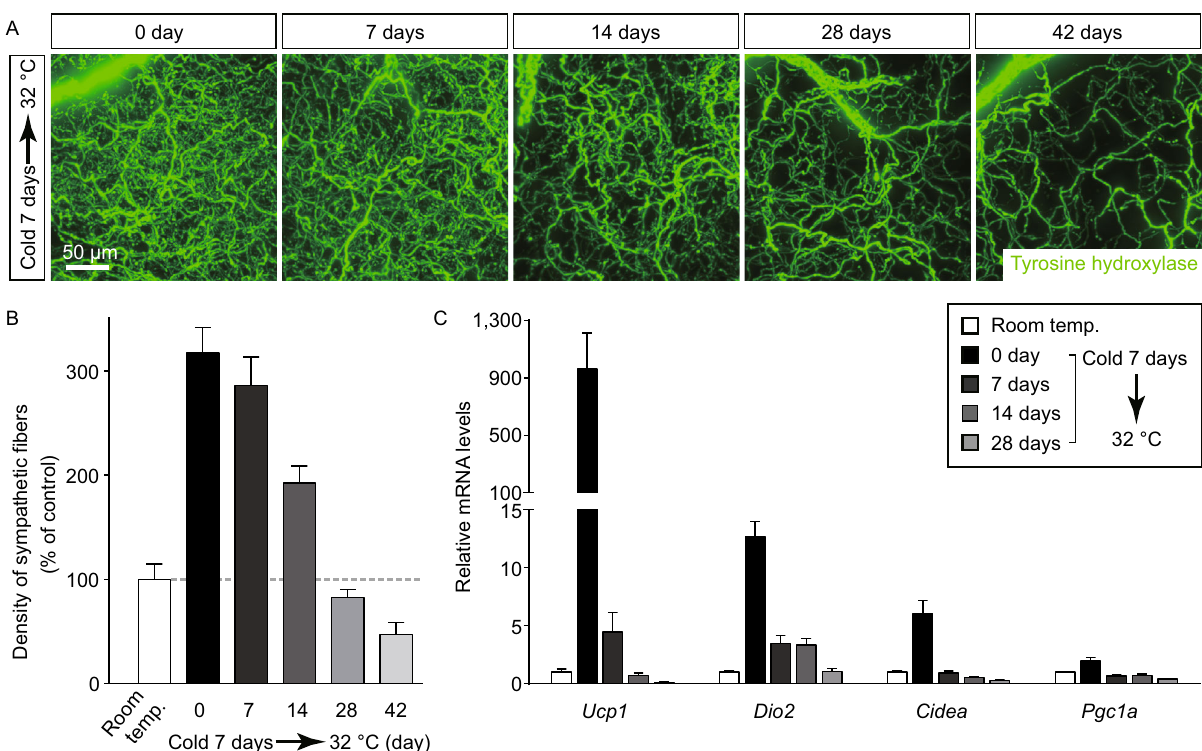
Figure 2. Cold-induced intra-adipose sympathetic plasticity is reversible. The wildtype mice were subject to cold challenge, and then recovered at thermal-neutral condition (32 °C). (A) Representative 3D projections of iWAT harvested at indicated time points, immunolabeled by anti-tyrosine hydroxylase, and imaged at 12.6× magni fi cation on the lightsheet microscope. (B) Density of the sympathetic fi bers in iWAT was quanti fi ed. n = 5, mean ± SEM. (C) Expression levels of the beiging-related genes were determined at indicated time points by the qPCR analysis. n = 5, mean ±